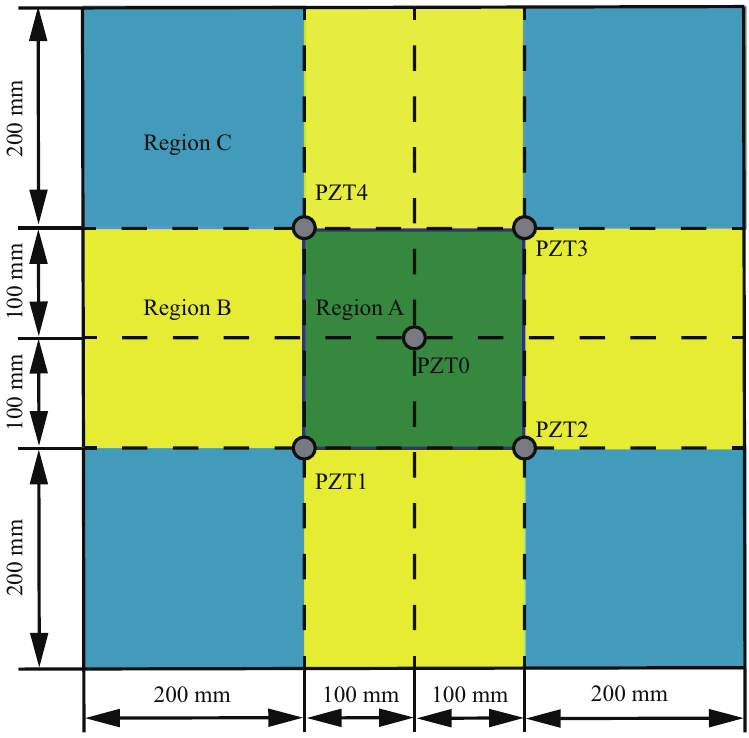
Figure 5. The schematic of specimen area division. The prefabricated hole damage centers in the three regions are D A ( 220, 360 ) , D B ( 320, 440 ) and D C ( 460, 440 ) , respectively. In order to distinguish the damages in the three regions, these damages are called Case I, Case II and Case III, as shown in Figure 6.